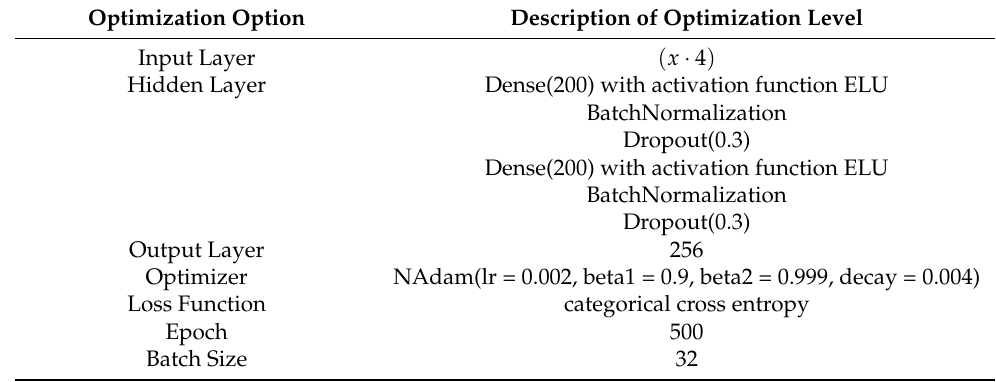
Table 4. Hyperparameters used in MLP model.